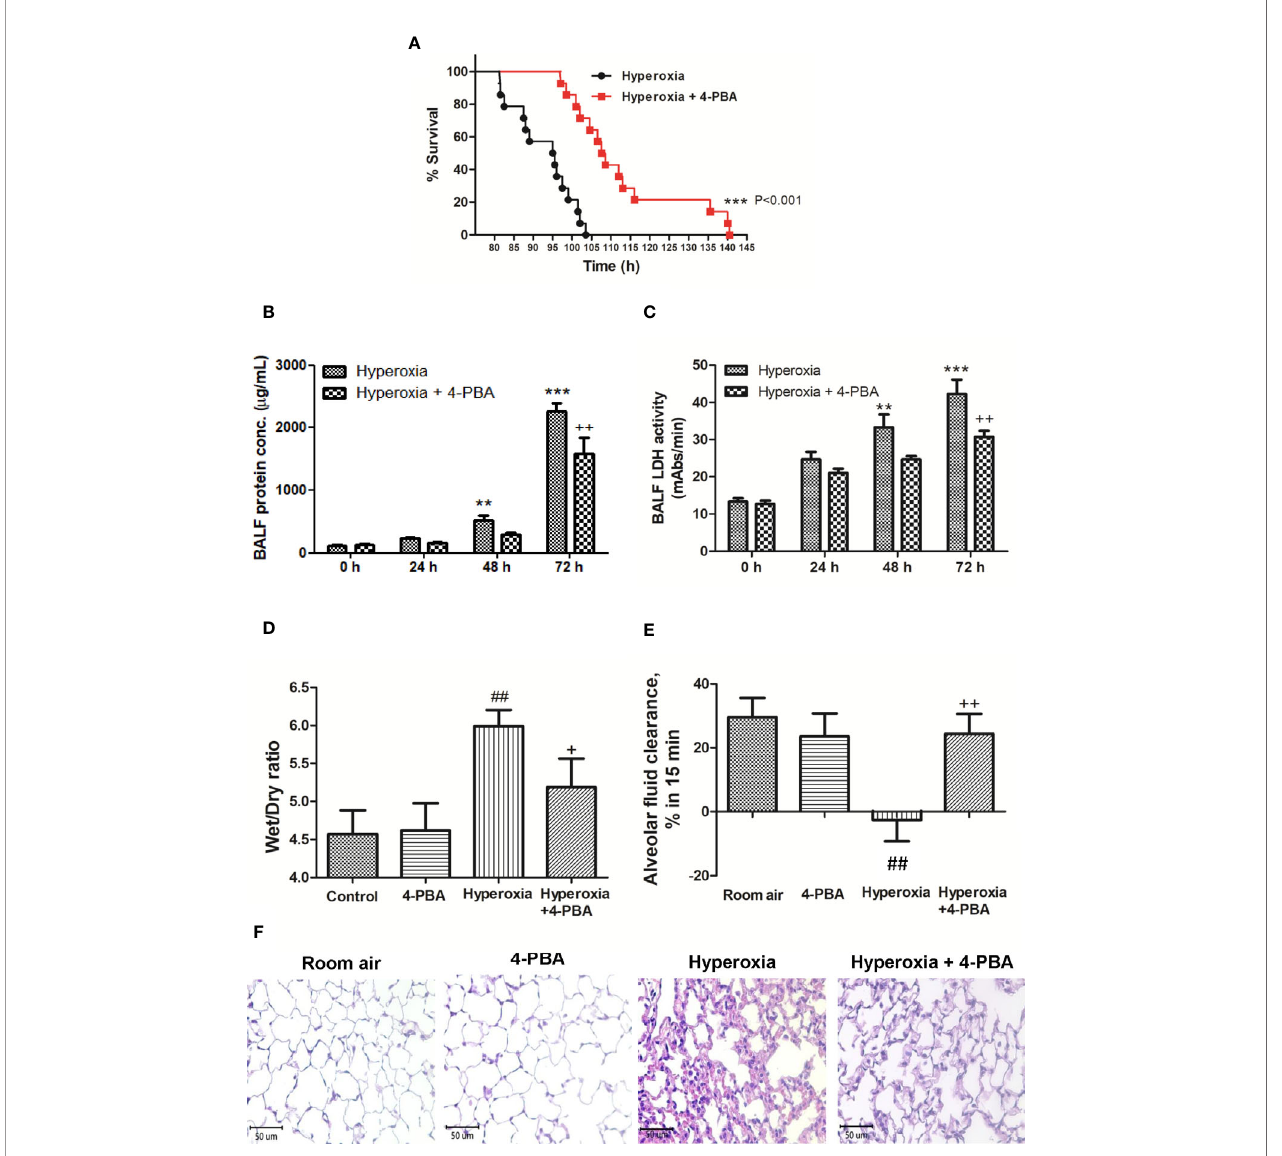
FIGURE 1 | 4-PBA prolonged survival rate, and improved lung edema and lung histopathology in mice with hyperoxia-induced lung injury. Survival was determined every 5 hours. The Kaplan – Meier survival curve was plotted and the difference in survival between the groups was signi fi cant (p < 0.001, log-rank test) (A) . Protein concentration in bronchoalveolar lavage fl uid (BALF) (B) , BALF lactate dehydrogenase (LDH) activity (C) , and lung wet/dry ratio (W/D) (D) signi fi cantly increased in the hyperoxia group. Treatment with 4-PBA signi fi cantly attenuated the increase in these parameters. In addition, the 4-PBA increased AFC in mice exposed to hyperoxia 72 hours (E) . 4-PBA treatment signi fi cantly reduced thickening of the alveolar walls and neutrophil in fi ltration in the hyperoxia group. (representative results, Bar = 50 µm, hematoxylin, and eosin staining) (F) . Data are expressed as mean ± SD (6 mice per group). **p < 0.01, ***p < 0.001, compared with the 0 hour group; + p < 0.05, ++ p < 0.01, compared with the hyperoxia (72h) group; ## p < 0.01 compared with the room air